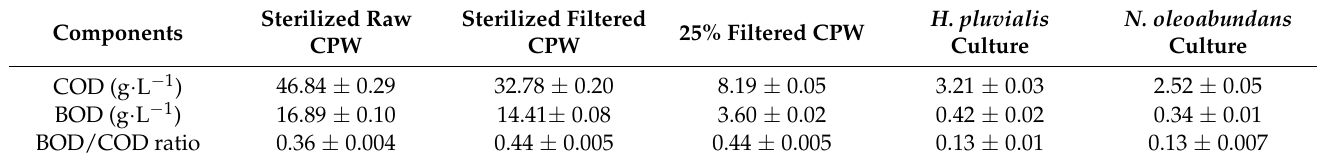
Table 5. COD and BOD removal efficiency by H. pluvialis and N. oleoabundans cultures.